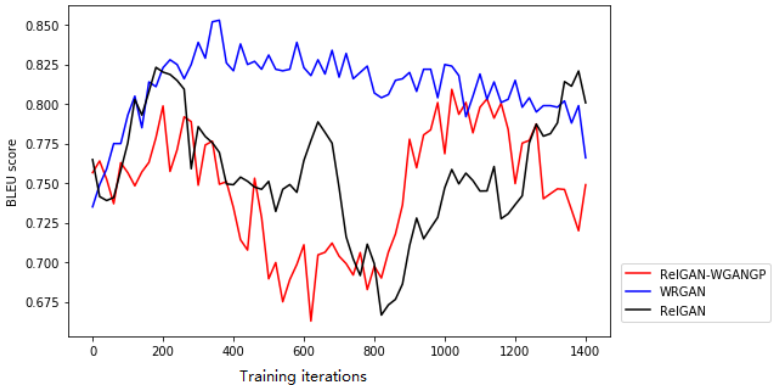
Figure 6. The BLEU-2 scores on the COCO image captions compared with